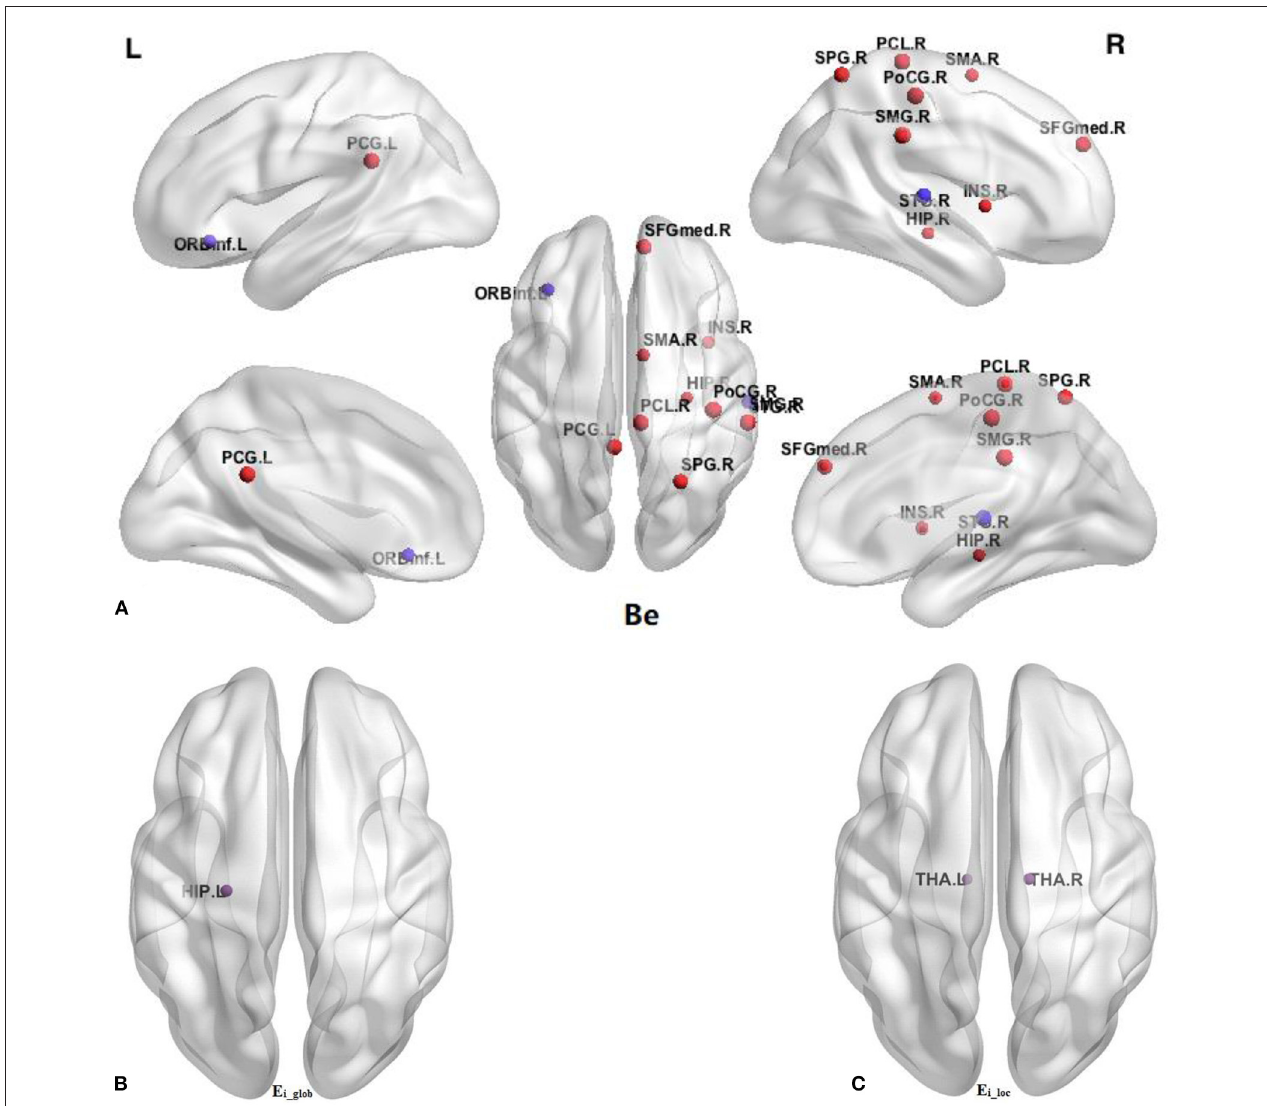
FIGURE 2 | Comparison of nodal parameters of the whole brain functional connectivity network between BQD group and HC group. (A) Betweenness centrality (Be); (B) the nodal global efficiency (E i_glob ); (C) the nodal local efficiency (E i_loc ). The node size reflects the degree of attribute difference. Red indicates the increase in nodal parameters in the BQD group, while purple indicates the decrease in nodal parameters in the BQD group. ORBinf, orbital part of inferior frontal gyrus; SMA, supplementary motor area; SFGmed, medial superior frontal gyrus; INS, insula; PCG, posterior cingulate gyrus; HIP, hippocampus; PoCG, post-central gyrus; SPG, superior parietal gyrus; SMG, supramarginal gyrus; PCL, paracentral lobule; STG, superior temporal gyrus; THA, thalamus; L, left; R,